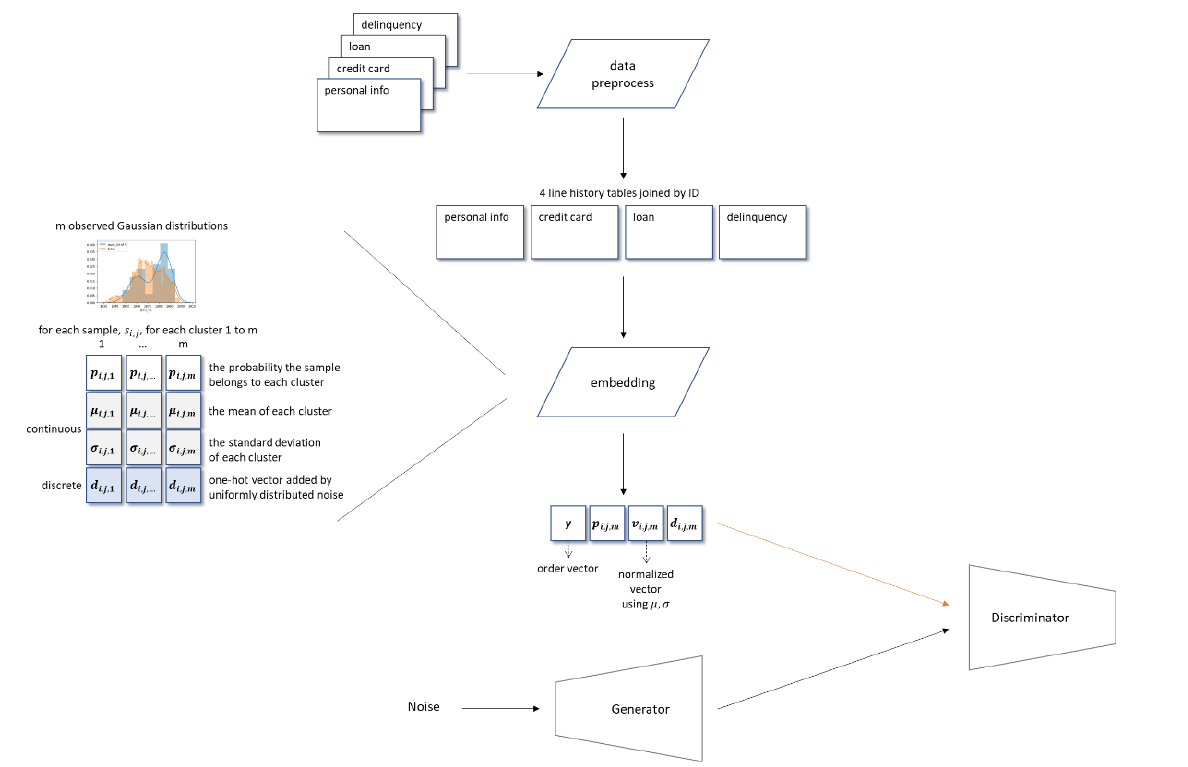
Figure 3. Data preprocessing and embedding.